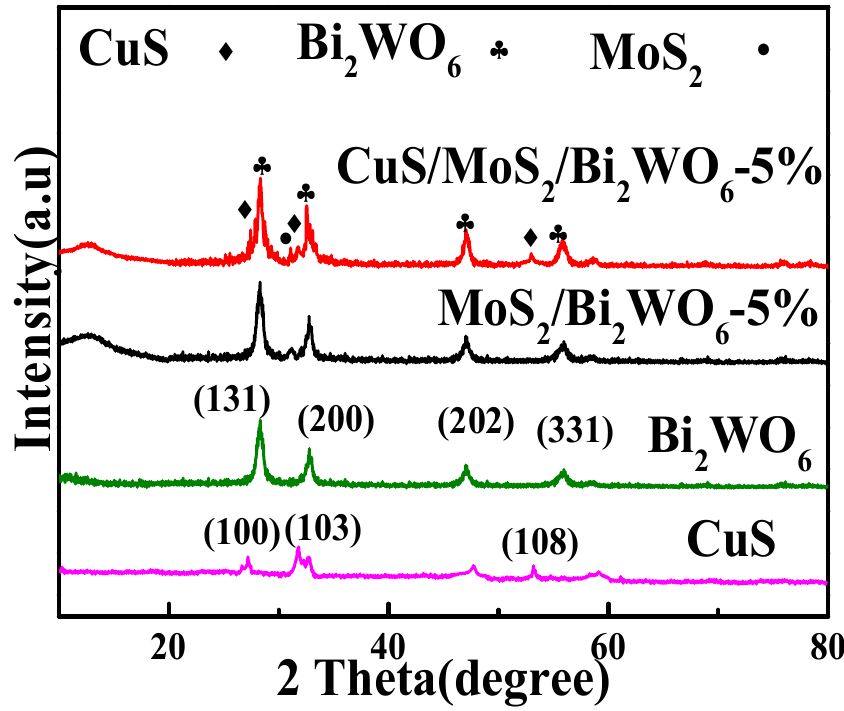
Figure 1. XRD patterns of CuS, Bi 2 WO 6 and MoS 2 /Bi 2 WO 6 -5%, CuS/MoS 2 /Bi 2 WO 6 -5% nanocomposites. XPS (Figure 2) confirmed the existence of Cu, S, O, Bi, W, and Mo in the chemical composition and valence band structure of CuS/MoS 2 /Bi 2 WO 6 -5%. The high-resolution spectrum of Bi (Figure 2A) exhibited two distinct peaks for electrons in the Bi 4f orbitals at 158.8 and 164.2 eV under the distributions on Bi 4f7/2 and Bi 4f5/2 [31]. Figure 2B depicts the spectra for O 1 s which is resolved into peak positions captured at 529.2 and 530.9 eV corresponding to the lattice oxygen in the microstructure and surface-adsorbed oxygen from the atmosphere, respectively [32]. The distinctive peaks at 34.9 eV and 36.9 eV for W 4f7/2 and W 4f5/2 (Figure 2C) were due to the presence of W atoms in the +6 oxidation state [33]. Figure 2D matches Mo 3d3/2 at 231.6 eV and Mo 3d5/2 at 228.4 eV with Mo 4+ [34]. The XPS spectra of Cu 2p is shown in Figure 2E, with peaks centered at 932.4 eV (Cu 2p3/2) and 952.4 eV (Cu 2p1/2), indicating that Cu is present in the Cu 2+ state [35,36]. According to Figure 2F, the doublet peak at 167.9 eV was a candidate for S 2p1/2, while the peak at 162.5 eV was for S 2p3/2, indicating the presence of metal sulfides [37,38]. These XPS data and Figures S3 and S4 were consistent with the composition CuS/MoS 2 /Bi 2 WO 6 -5%. Figure 3 represents the TEM images of their nanocomposite, and Figure 3A,B depict the recording of the Bi 2 WO 6 and CuS/MoS 2 /Bi 2 WO 6 -5% microstructure and high-resolution imaging. The picture demonstrates the microstructure’s density, as indicated by the dif- ferential flakes protruding from the floral core structure. Additionally, to illuminate the growth planes in detail, high-resolution TEM (HR-TEM) in Figure 3D was used to calculate the interplanar spacing for 0.316 nm following the (131) plane of the Bi 2 WO 6 structure, due to the lattice spacing of 0.328 and 0.158 for overgrown CuS and MoS 2 , respectively, which arose from the (100) and (110) planes. Among Bi 2 WO 6 , CuS, and MoS 2 , an explicit interface that benefited photocatalysis by forming a heterojunction enabled the efficient transfer of charge